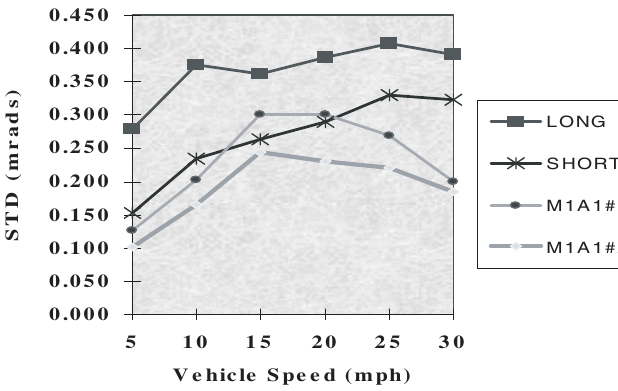
Fig. 10. Azimuth position error.